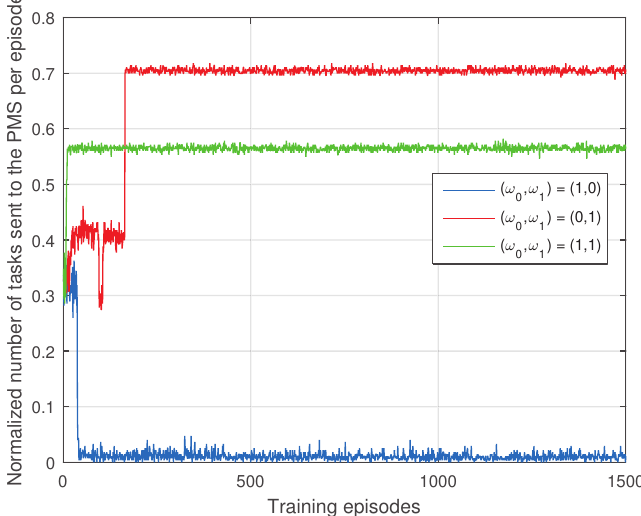
Figure 3. The impact of the weights on the normalized number of tasks sent to the PMS per